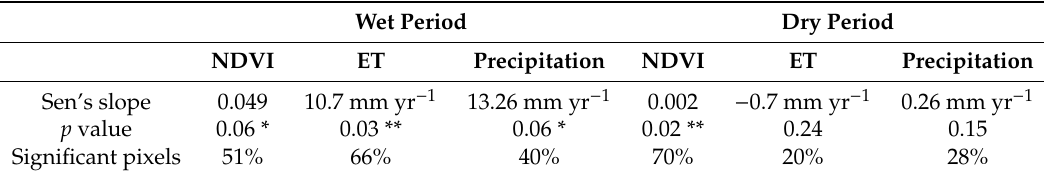
Table 2. Regional annual ET mean changes in the DP System from 2002 to 2014. NDVI mean change for the study period 2002–2014. Statistics obtained from the non-parametric Mann-Kendall